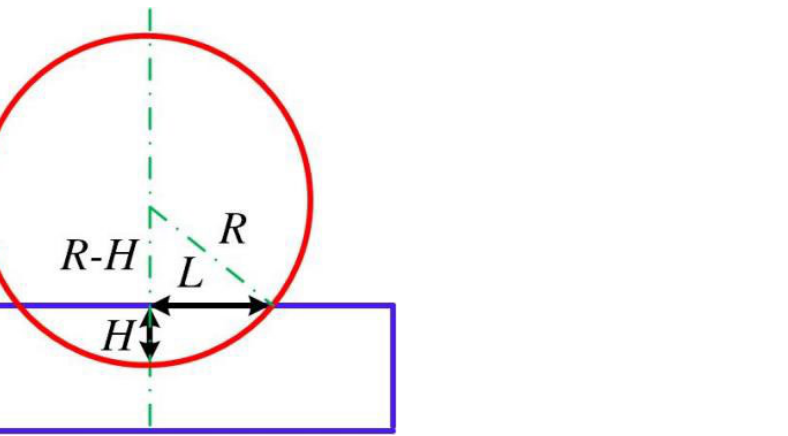
Figure 3. Estimate of the horizontal length scale L . The red denotes the contour of the drop and the blue signifies that of the substrate.